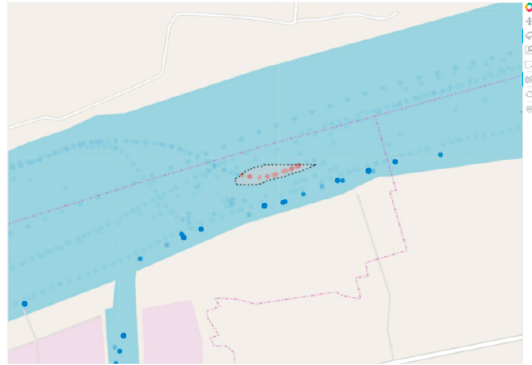
Figure 7. Lasso selection of trajectory points.